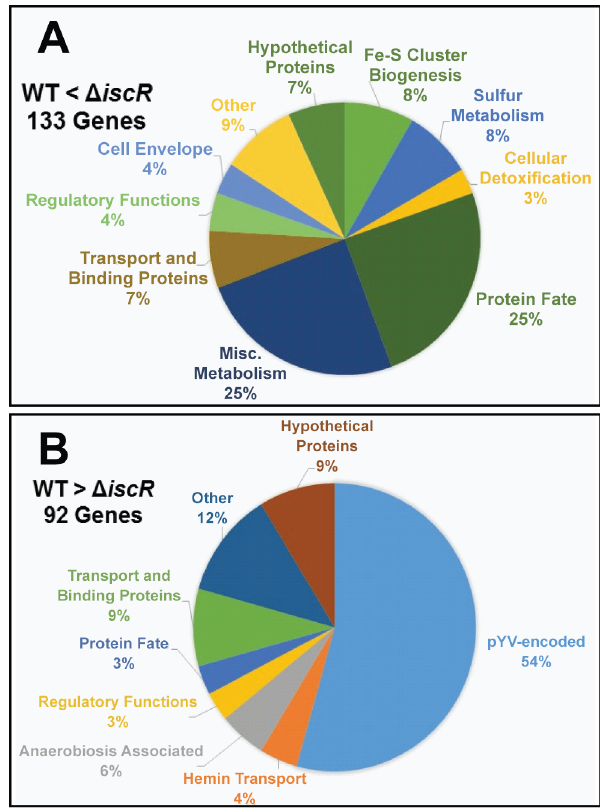
Figure 4. IscR impacts global gene expression in Y.pseudotu- berculosis under iron replete conditions. RNAseq analysis was performed on WT and D iscR Y. pseudotuberculosis after growth in M9 at 37 u C for 3 h (T3SS-inducing conditions), at which point total RNA was collected and processed. The resulting libraries were sequenced using the HiSeq2500 Illumina sequencing platform for 50 bp single reads and analyzed via the CLC Genomics Workbench application (CLC bio). RPKM expression levels of 225 genes demonstrated a fold change of $ 2, and were deemed significant by Bayseq test with a corrected FDR post hoc test from three independent experiments (p # 0.05). Shown are the functional ontologies of the ( A ) 133 genes that are up-regulated in the D iscR mutant relative to the wild type and ( B ) 92 that are